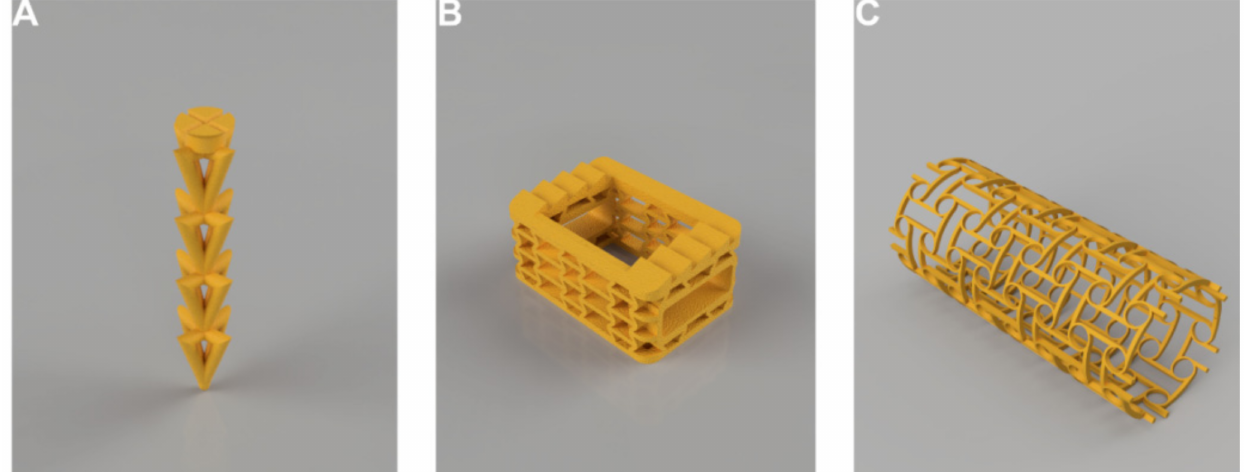
Figure 4. Examples of CAD models of different medical devices benefiting from employing auxetic units or having an auxetic geometry. ( A ) Auxetic insert for enhanced surgical fixation. ( B ) Spine disc replacement made of auxetic lattices for biomimetic performance. ( C ) 2D auxetic geometry mapped upon a cylinder to obtain an auxetic stent with improved implantation and adhesion.